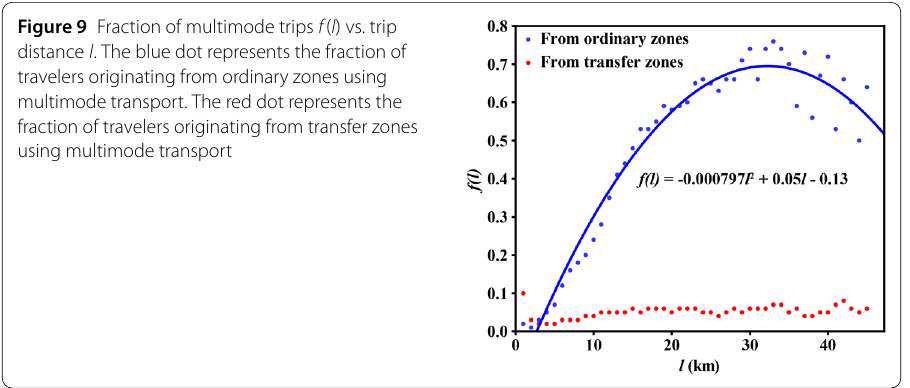
Figure 9 Fraction of multimode trips f ( l ) vs. trip distance l . The blue dot represents the fraction of travelers originating from ordinary zones using multimode transport. The red dot represents the fraction of travelers originating from transfer zones using multimode